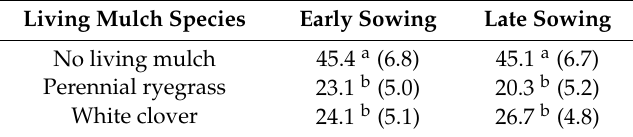
Table 4. Average weed density ( n m − 2 ) and standard error in parenthesis averaged over the fixed factors living mulch species and time of living mulch sowing in all seven experiments; no interactions between living mulch species and sowing date were found; time of sowing was not significant; means with identical letters within each experiment do not differ significantly based on the Tukey-HSD test ( p <